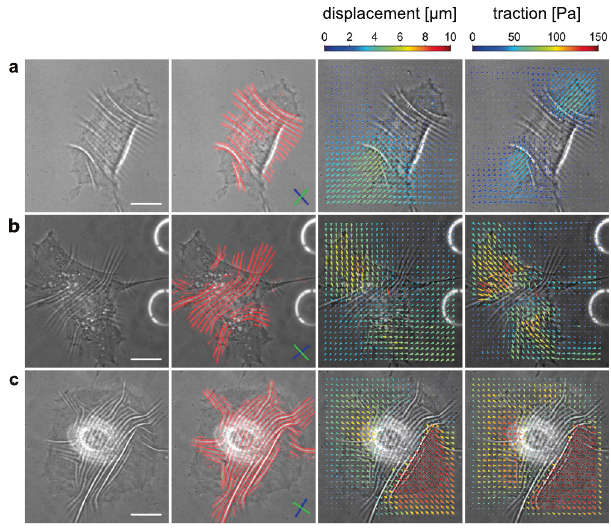
Fig. 2 Three examples of the simultaneous measurement of wrinkles and traction forces. Each column a – c describes (from left to right) raw image, wrinkles (red lines), displacement fi eld and traction force fi eld. The white scale bar in the fi rst column images is 20 μ m. The blue and green lines inside the second column images describe the principal direction of the wrinkle and the traction,